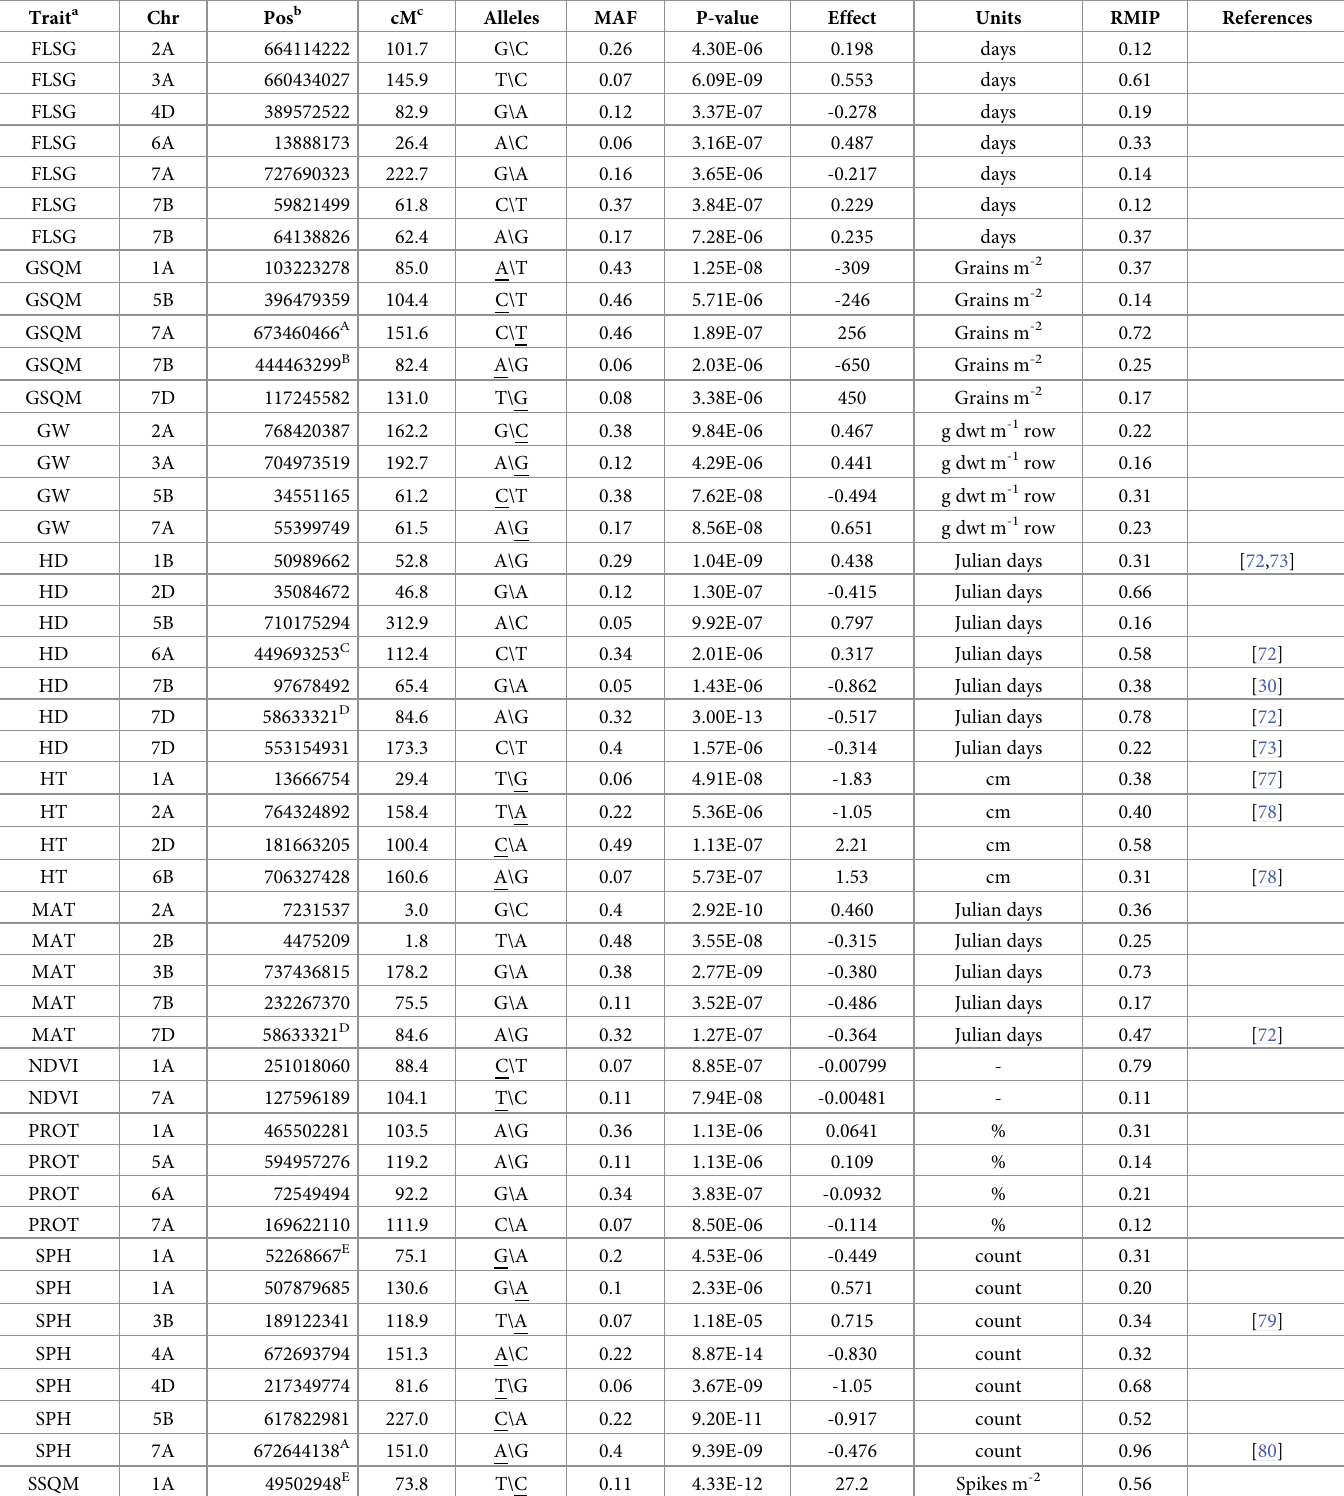
Table 4. Significant marker-trait associations identified by the FarmCPU